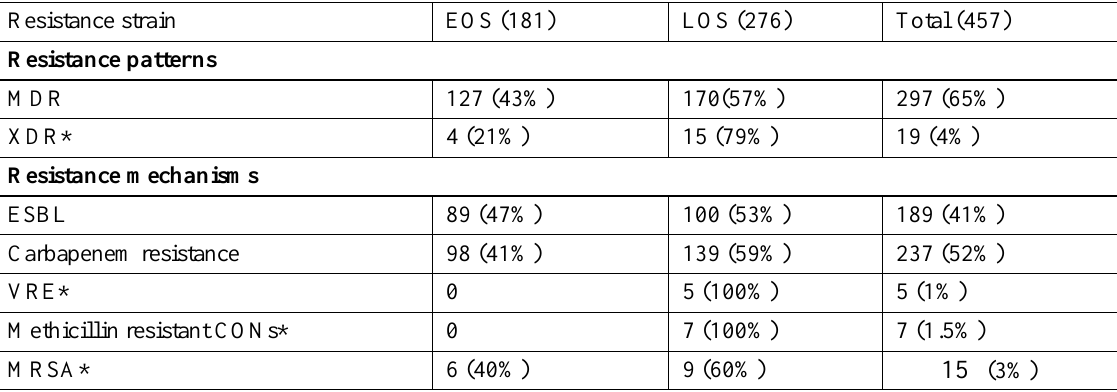
Table 5. Comparison between the isolated resistant strains patterns and resistance mechanisms in EOS & LOS.